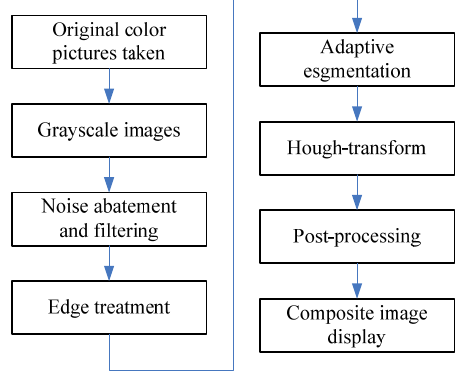
Figure1 Brief processing of reversing images